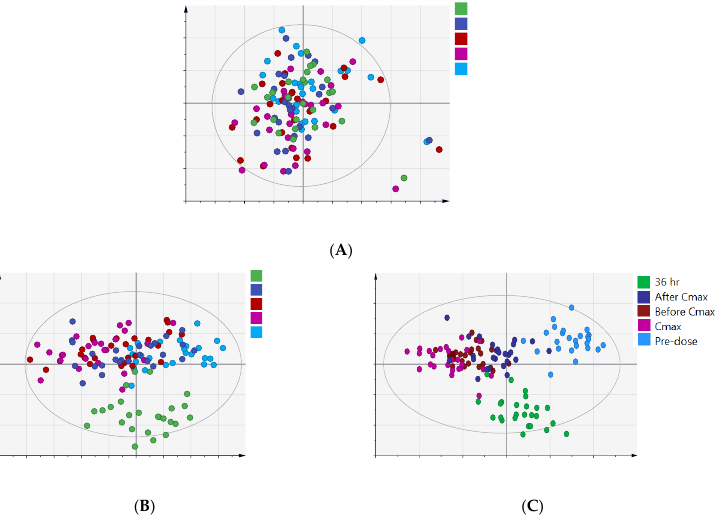
Figure 1. Score plots of the lipidome of serum samples were obtained from 26 healthy subjects after a single dose of metformin at five − time points: predose (baseline level, light blue), 1.5 h before Cmax (red), Cmax (purple), 2 h after Cmax (dark blue), and 36 h post − drug administration (green). ( A ) PCA (R 2 X = 0.68, Q 2 = 0.42), ( B ) PLS − DA (R 2 X = 0.28, R 2 Y = 0.39, Q2 = 0.15) and ( C ) OPLS − DA (R 2 X = 0.30, R 2 Y = 0.39, Q 2 = 0.23).